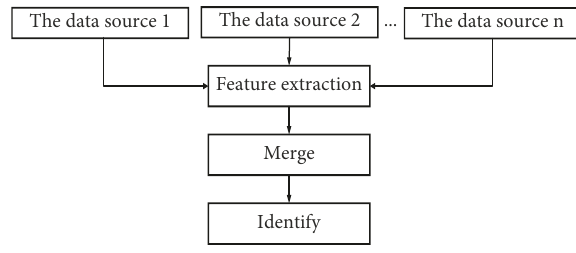
Figure 1: Flowchart of data layer